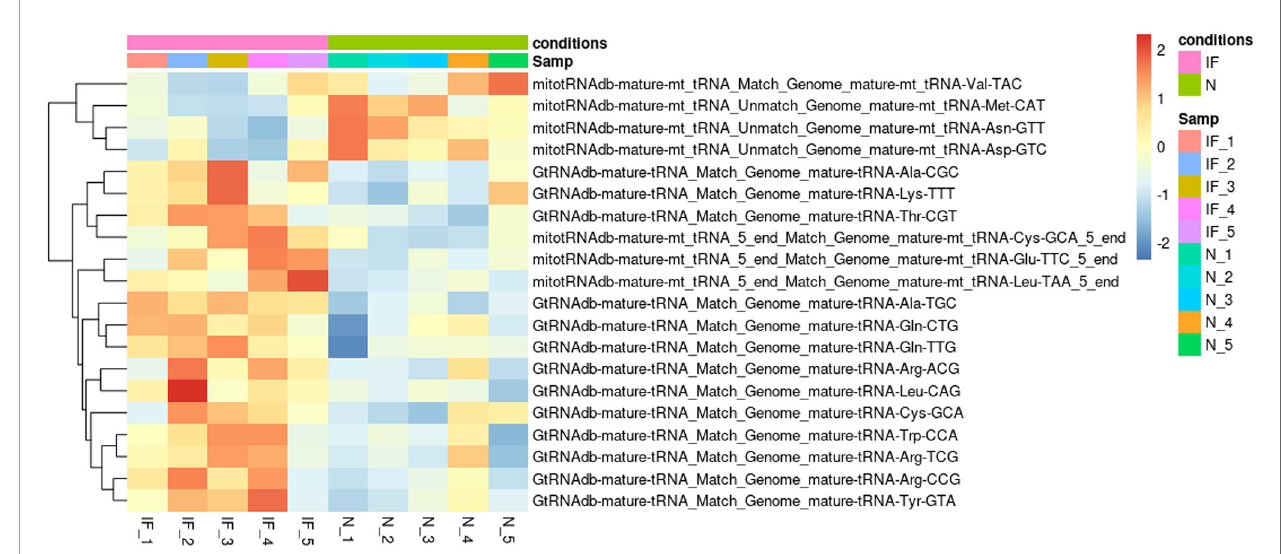
FIGURE 7 | Distinct tsRNA expression pattern in CE and the controls. Heatmap plot showed the expression pattern of the top 20 distinct tsRNAs. The Vertical axis indicated the precursor of tsRNAs. P > 0.05. IF represented the in fl amed epididymides, and N indicated the